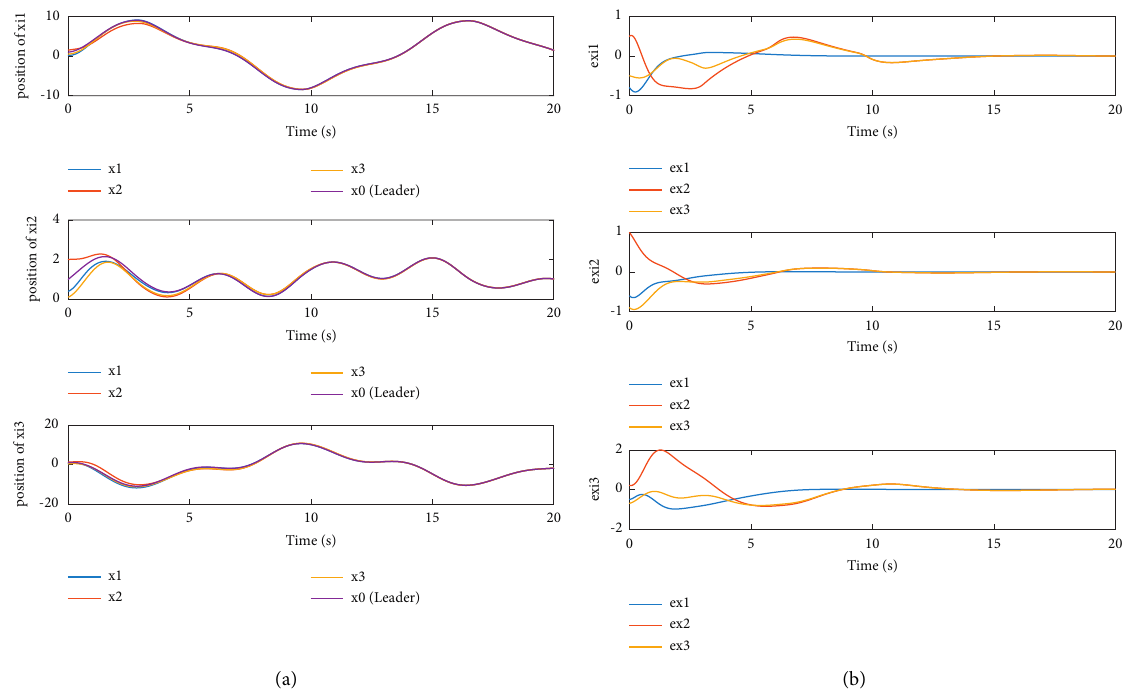
Figure 7: Position state and position error. (a) Position state. (b) Position